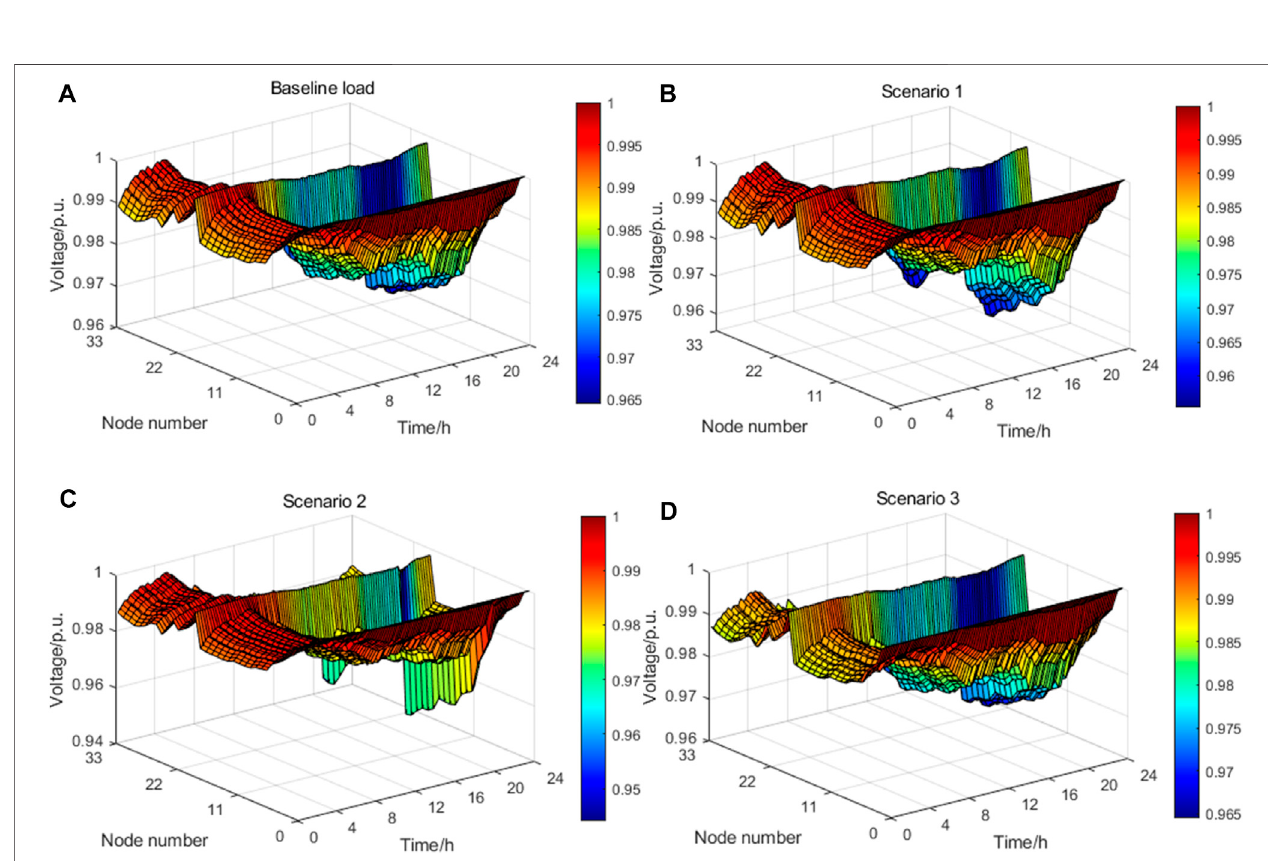
FIGURE 10 | Nodal voltage surface diagram. (A) Baseline load. (B) Scenario 1. (C) Scenario 2. (D) Scenario 3.